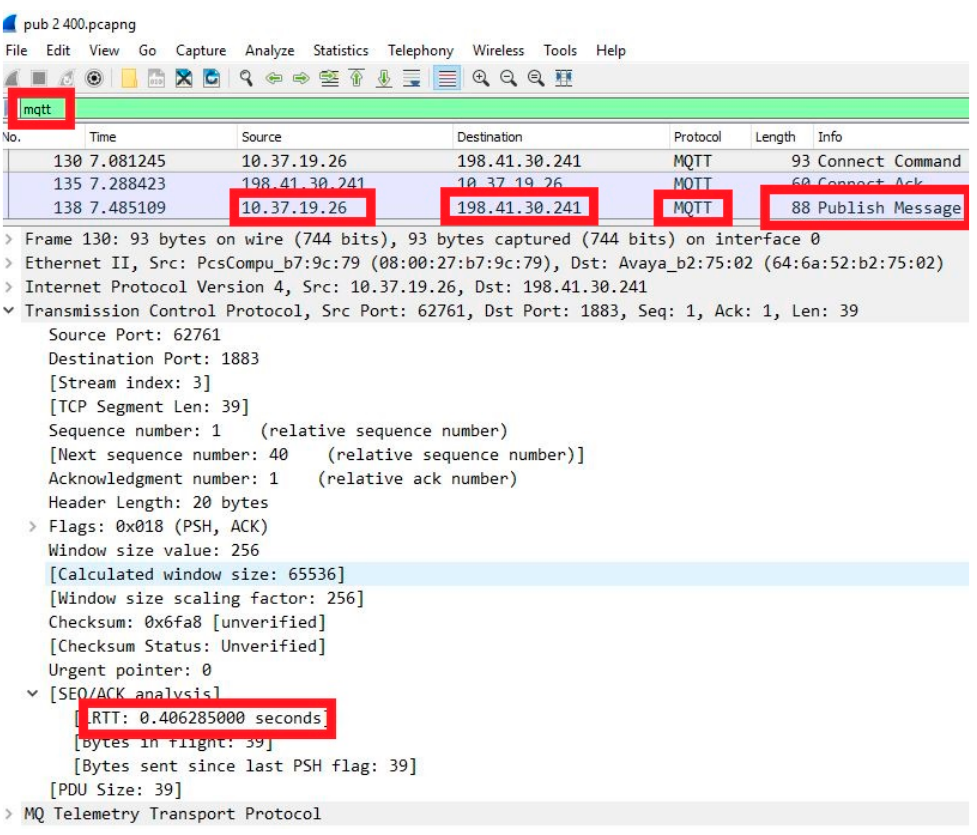
Figure 21. Communication delay implementation for case Bb.